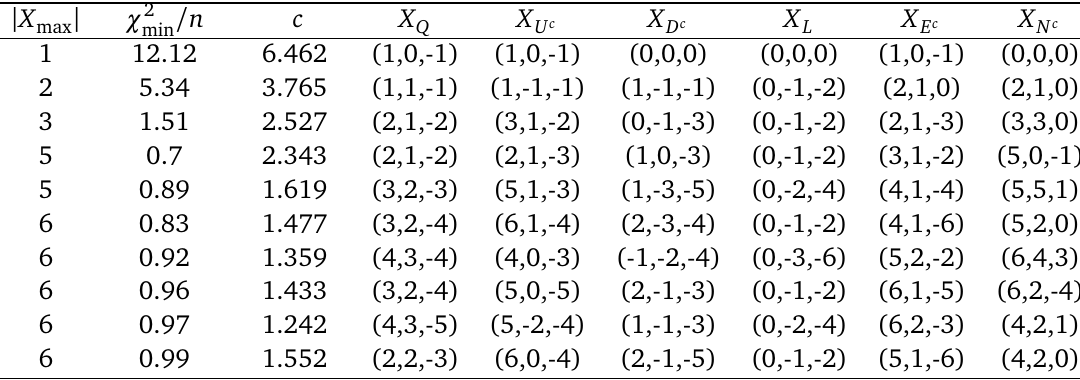
Table 4: The best fit solution for each | X of RH neutrinos. We also give inequivalent solutions for which χ 2 | X | = 4, no new better solution is max